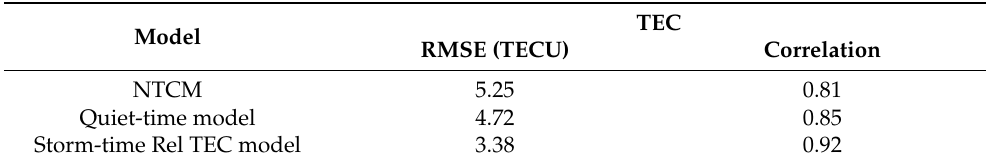
Table 3. Quality measures, in terms of RMSE and correlation for the TEC, of the NTCM, quiet-time and storm-time relative TEC model.